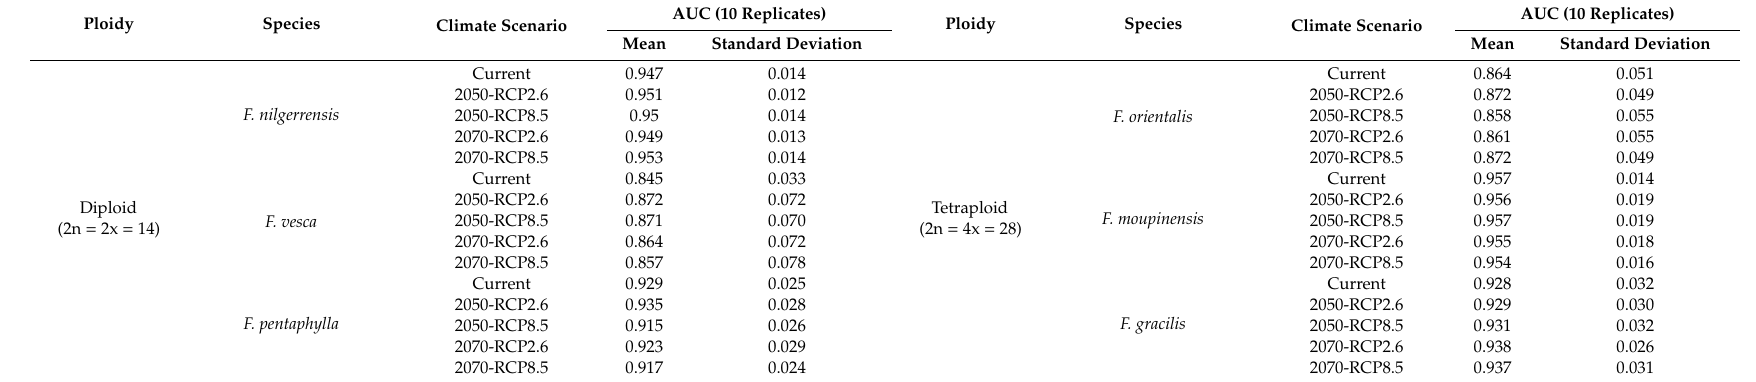
Table 1. AUC values for the ten replicates of six wild strawberry species under five di ff erent climate